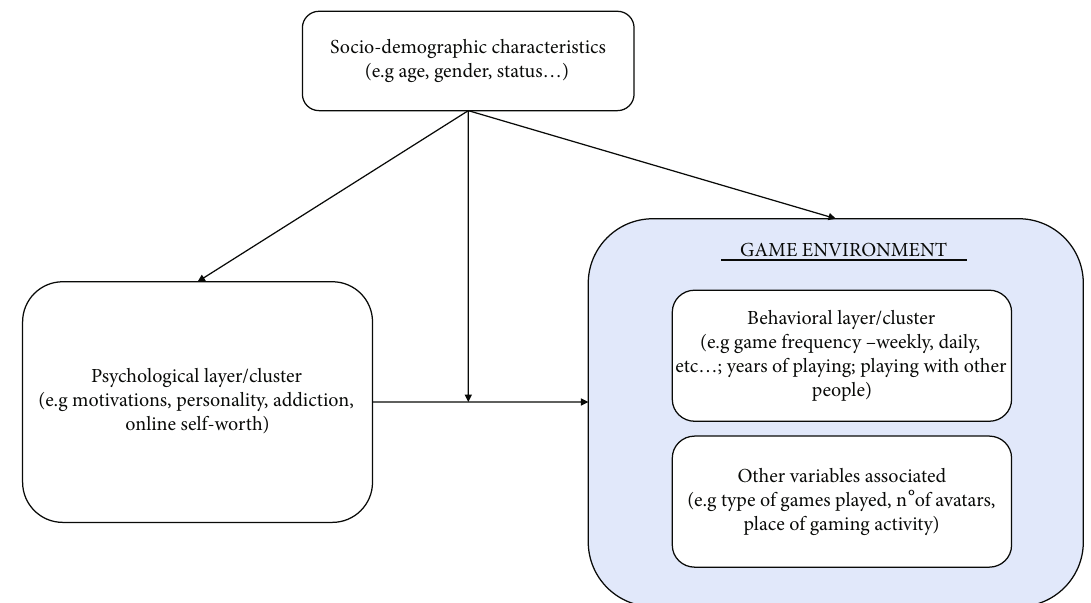
Figure 2: Theoretical metamodel suggested to understand how each cluster is connected to each